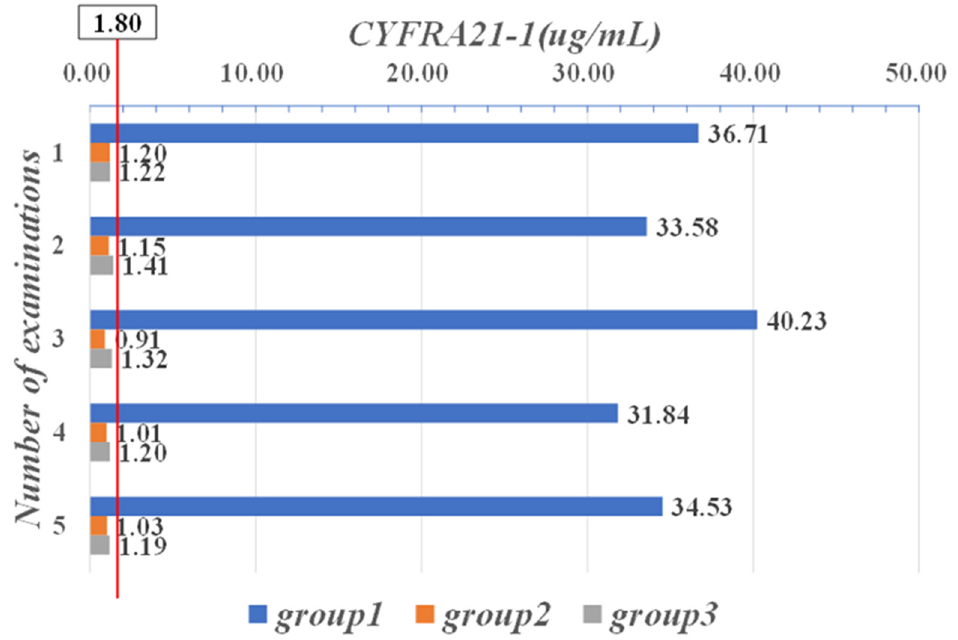
Figure 6. Mean data of five CYFRA21-1 examinations in three groups of patients.